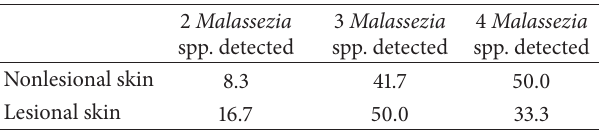
Table 4: Detection rates of multiple Malassezia spp. in the same sampling area